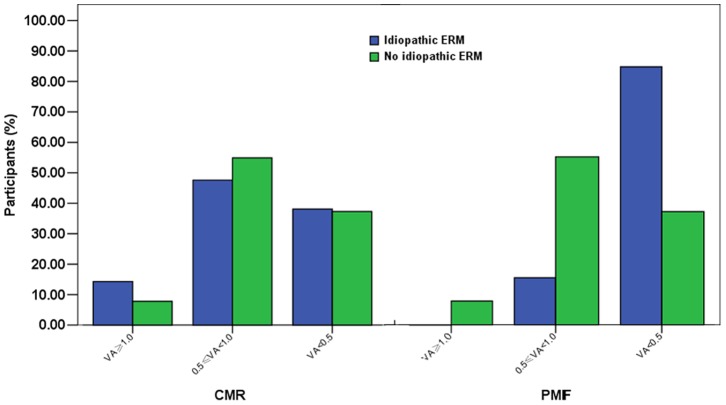
LogMAR presenting visual acuity of idiopathic epiretinal membranes (iERM) and no iERM.